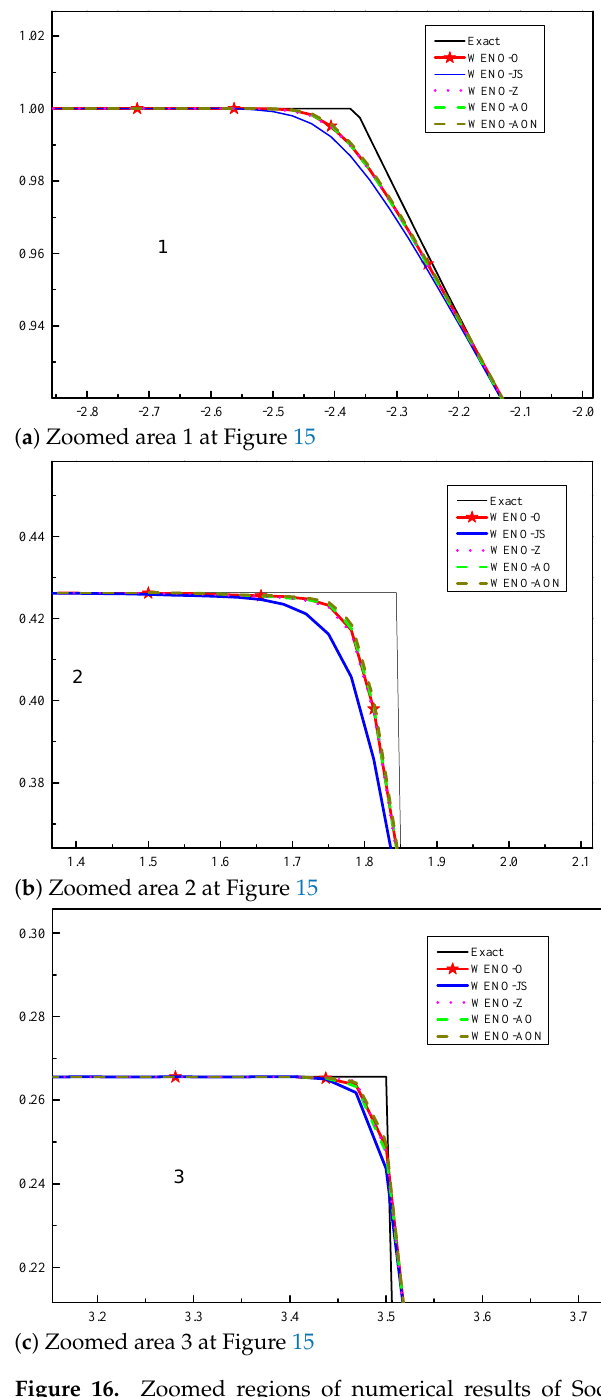
Figure 16. Zoomed regions of numerical results of Sod’s problem of Example 5 (Figure 15) (Section 6.2.2) for density field at time t = 2, CFL = 0.1 with 320 cells for the considered WENO